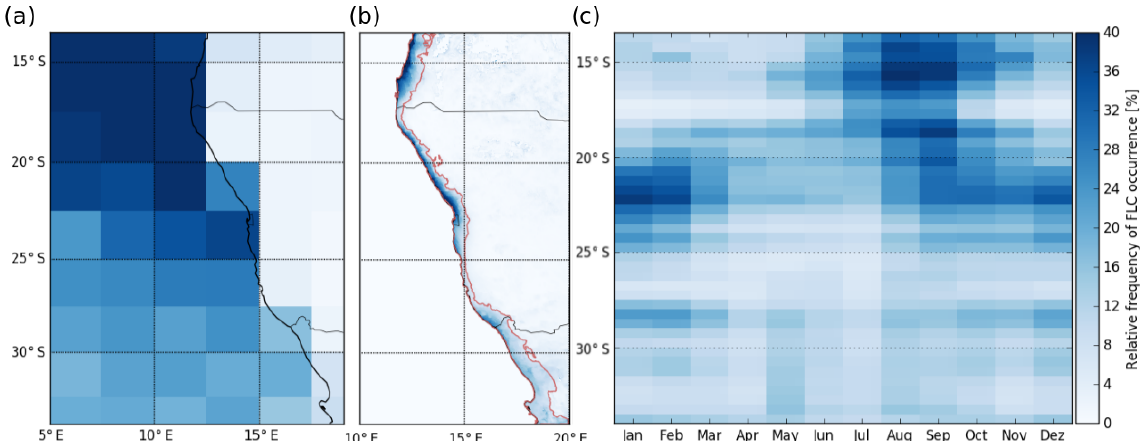
Figure 2. A satellite-based climatology of relative fog and low cloud occurrence frequency derived by using the algorithms presented in Cermak (2018) (a) and Andersen and Cermak (2018) (b) , based on the nearly complete data records of CALIPSO (2006–2017) and SEVIRI (2004–2017). Daytime and nighttime overpasses (approximately 13:00 and 01:00UTC, respectively) are averaged to produce panel (a) ; all SEVIRI time slots are used for panel (b) . The seasonality (c) is computed by averaging pixels from panel (b) in coastal regions (maximum 100km distance to coastline) with frequent FLC occurrence (minimum of 5% relative FLC occurrence in the 14-year climatology shown in panel b ). The regions used for averaging in panel (c) lie within the red contours in panel (b)